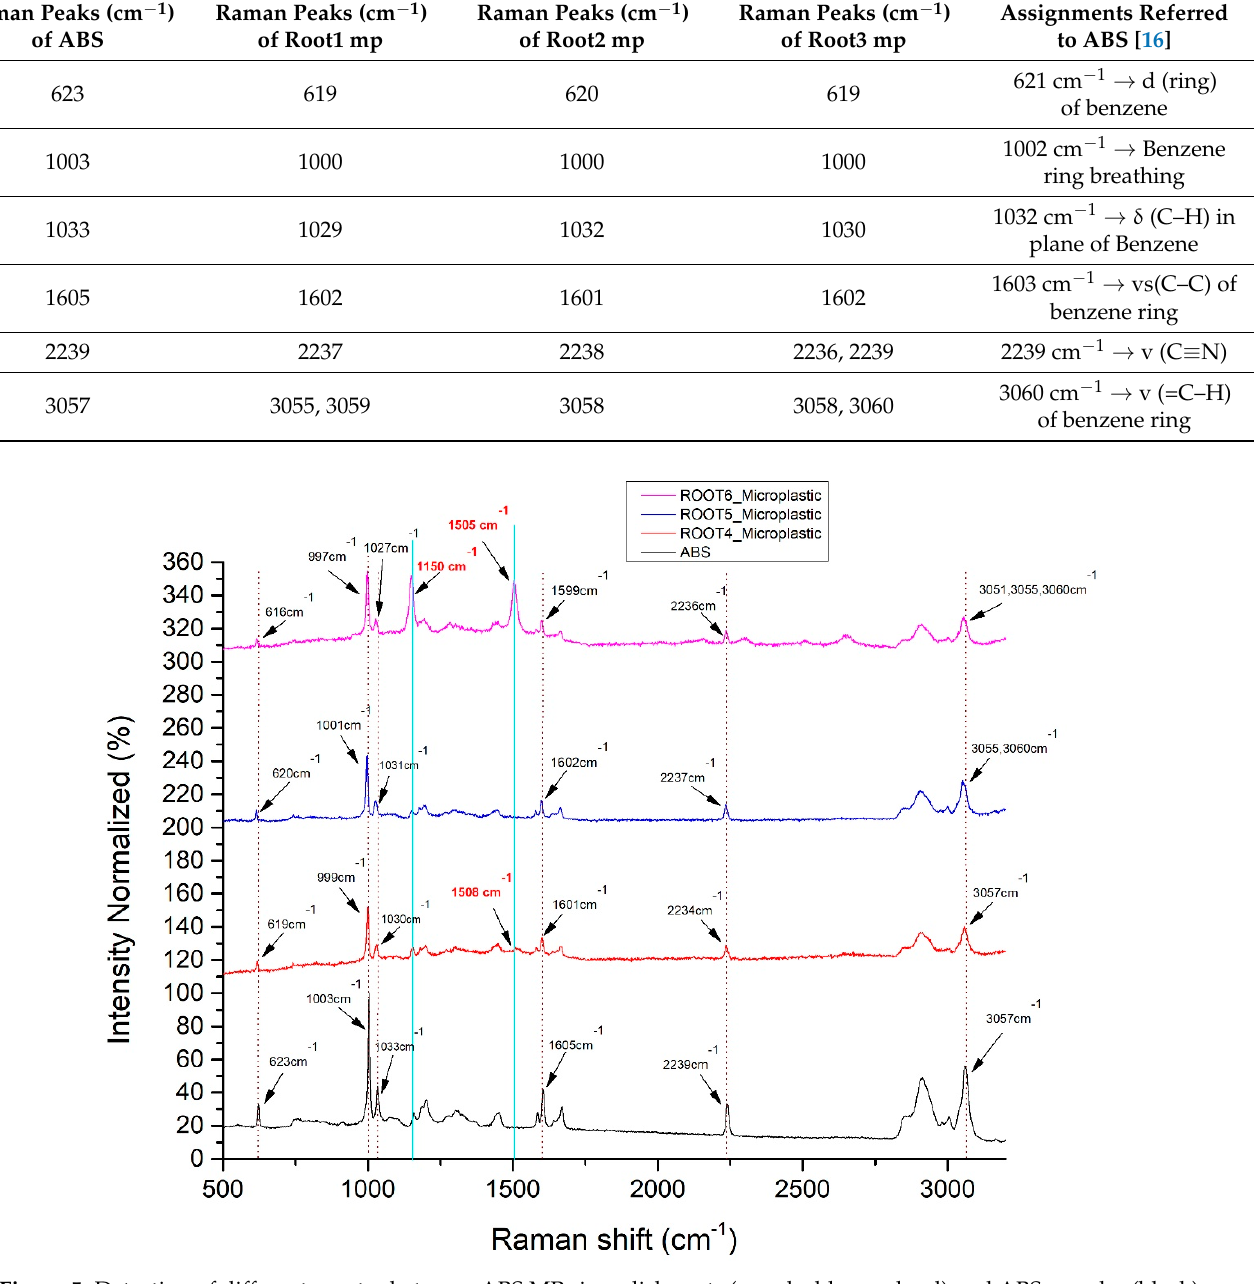
Figure 5. Detection of different spectra between ABS MPs in radish roots (purple, blue and red) and ABS powder (black). Raman fluctuating peaks are indicated with bold red.